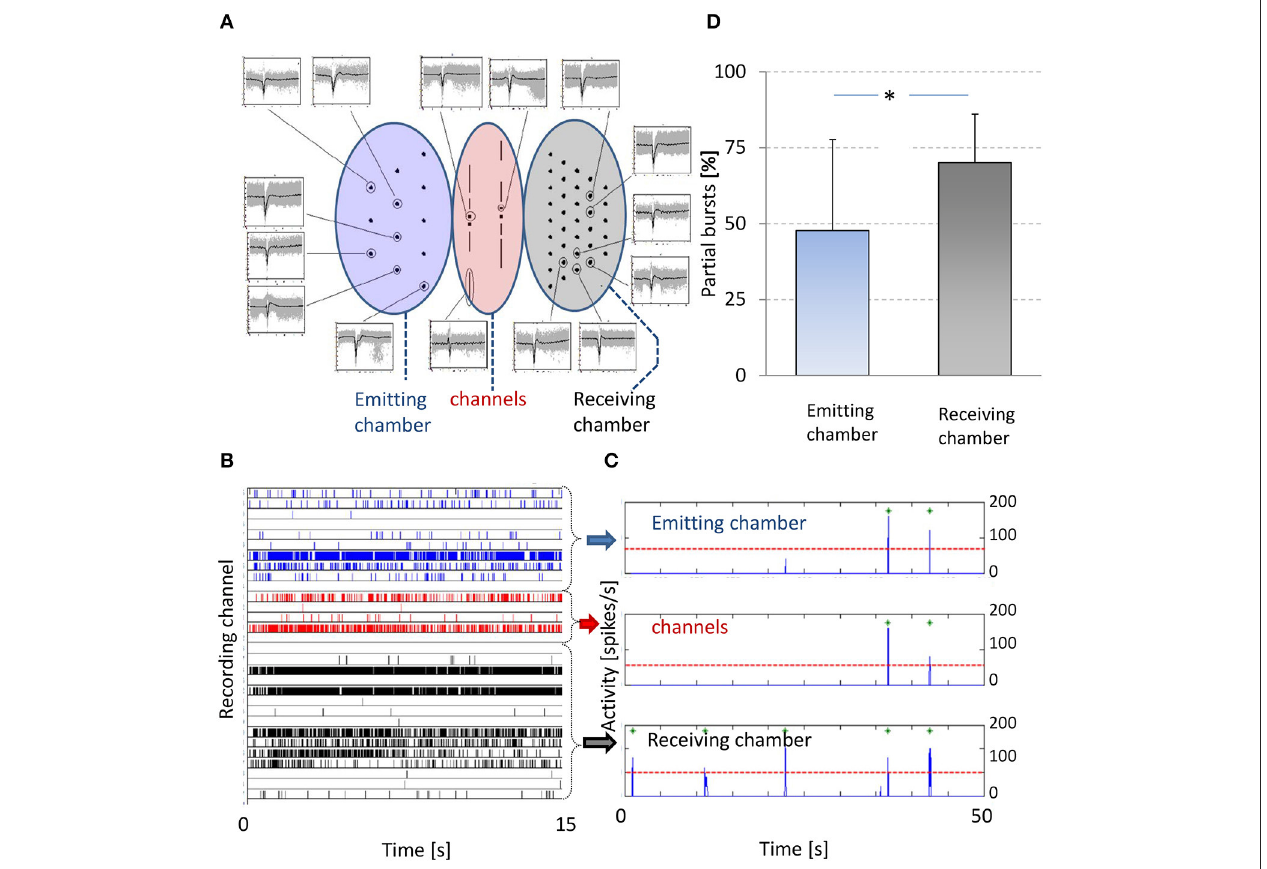
FIGURE 3 | Spontaneous activity. (A) Center shows electrode layout and the periphery shows recorded action potentials. Left oval area (blue) indicates electrodes in the emitting chamber, middle oval area (red) indicates channel electrodes and right oval area (gray) indicates electrodes in the receiving chamber. Examples of individual action potentials (gray) are shown and their average shapes (black) per electrode, obtained from a 10min recoding from a 3 weeks old culture. Only signals are shown of electrodes that recorded more than five spikes per minute. Horizontal axes span 6ms, vertical axes are scaled to fit; mean amplitudes ranged 50–300 µ V. (B) Raster plot of 15s of recorded activity. Vertical axis indicates all recording electrodes, action potentials recorded by an electrode are indicated by tics in the corresponding row. All tics are color-coded to indicate the location of the recording electrode, blue (rows 1–10): receiving chamber, gray (rows 16–30): emitting chamber, and red (rows 11–15): channels. (C) Summed activity in 5ms bins (blue line). A threshold (---) based burst detection algorithm found all bursts in either chamber and in the channels ( + ). (D) Percentages of partial bursts in the emitting (blue) and receiving chamber (gray). Partial bursts were defined as any burst that occurred in one chamber at t = τ with no burst in the other chamber during the interval t = [ τ − 400 ; τ + 400 ms]. The occurrence of partial bursts were expressed as percentages of the total number of bursts in either chamber. * paired t -test: p < 0.01